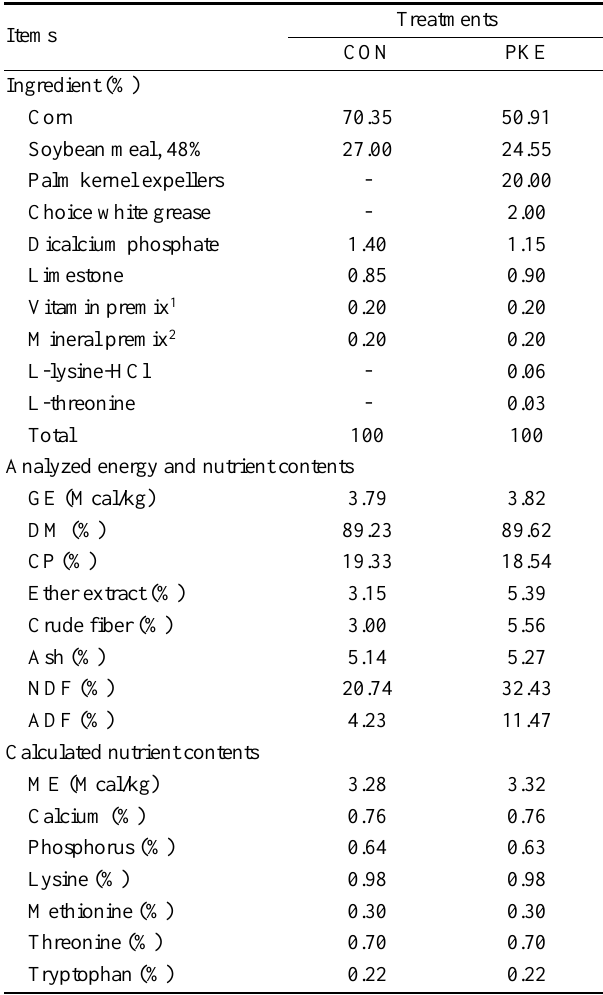
Table 1. Composition of experimental diets during lactation (as- fed basis) Items